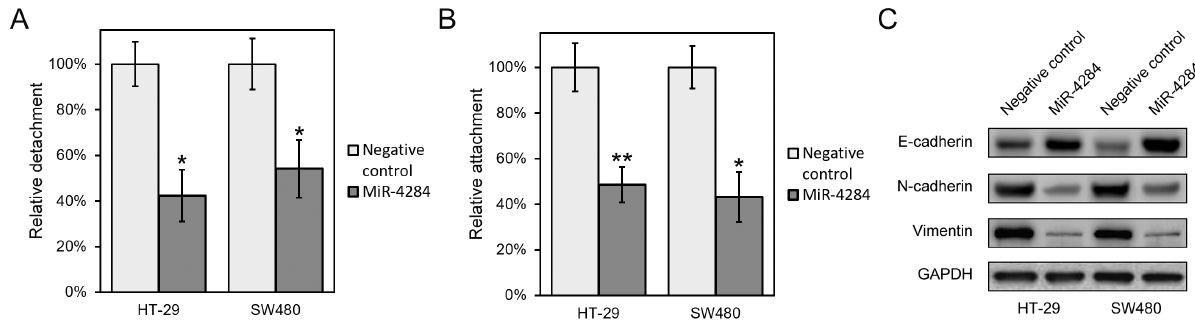
Figure 5. MiR-4284 inhibits epithelial-mesenchymal transition (EMT) of colon cancer cells. (A) Cell attachment and (B) detachment assays were conducted in HT-29 and SW480 cells transfected with either miR-4284 or miRNA negative control. Values were mean ± SD of 3 independent biological replicates; ** P < 0.01, * P < 0.05, compared to negative control. (C) Expression of EMT phenotypic proteins was assessed in HT-29 and SW480 cells transfected with either miR-4284 or miRNA negative